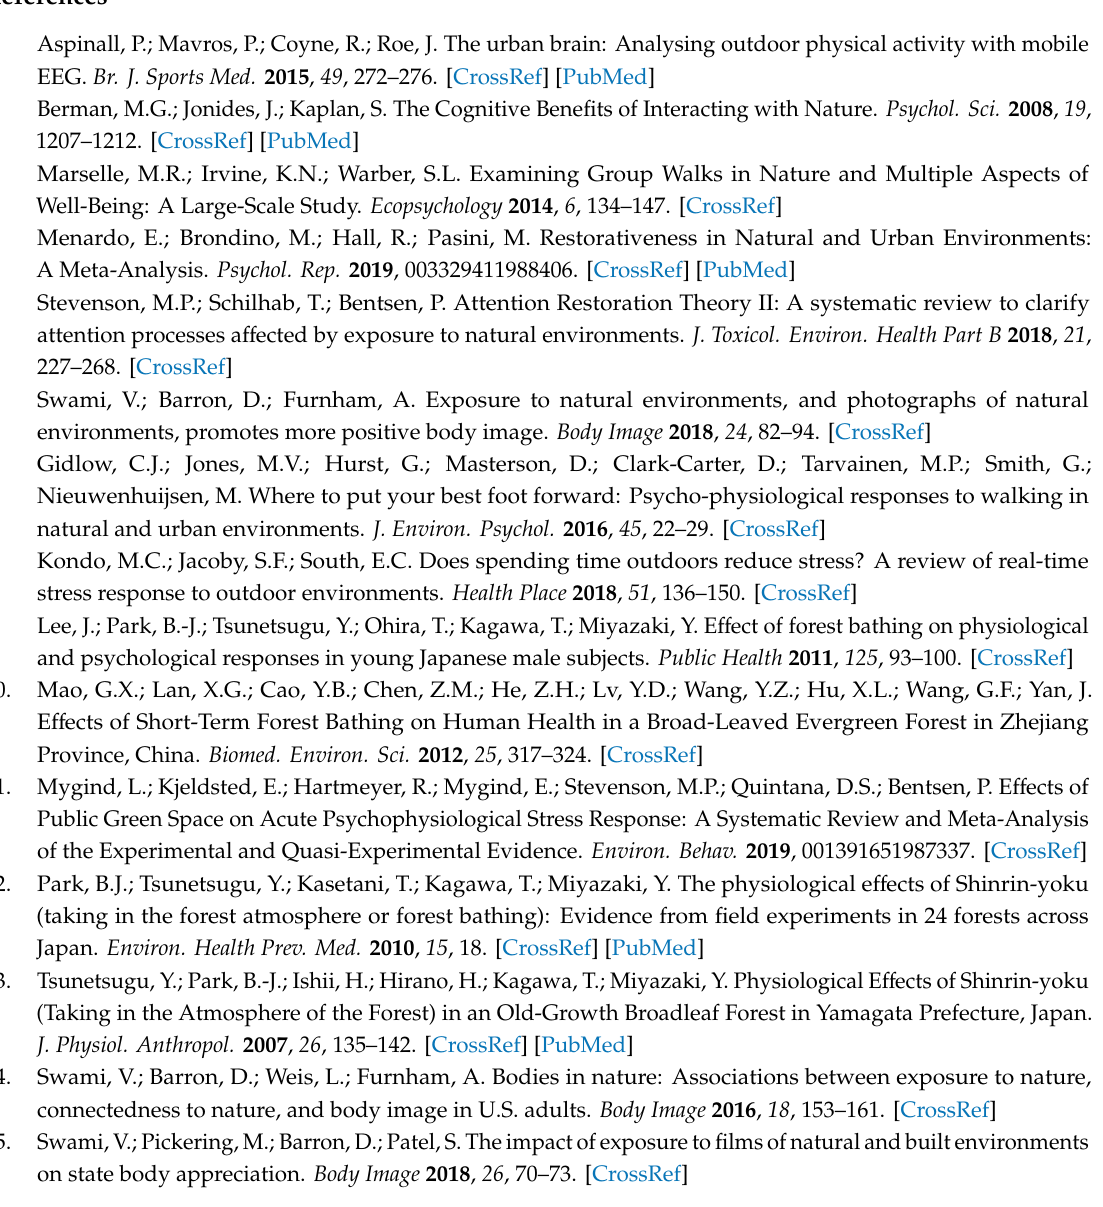
s1, Table S1: Correlations between attractiveness and stress ratings, Table S2: Correlations between self- and